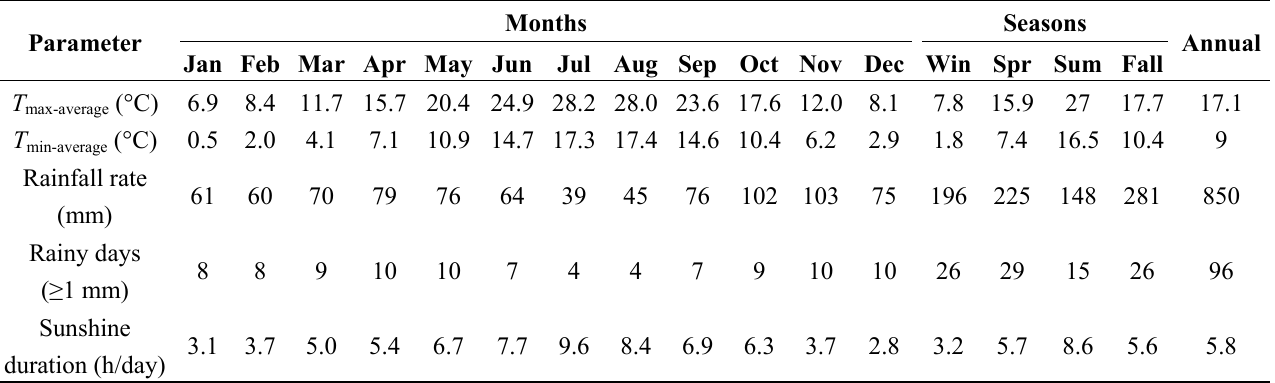
Table 1. Climate conditions and positioning of the case study